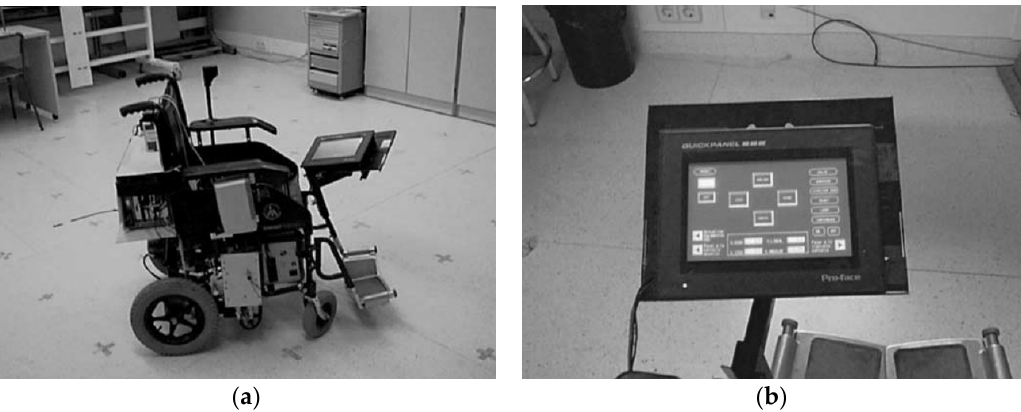
Figure 7. Wheelchair embedded with EOG input interface. ( a ) Overlook ( b ) Control display. Reprinted with permission from Ref. [15].